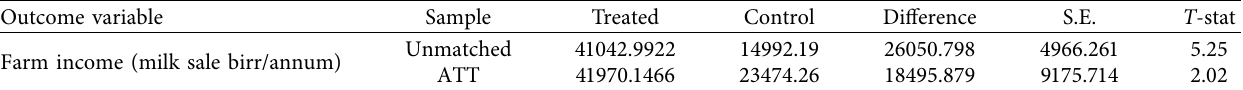
Table 11: Estimation of ATT for farm income (birr/annum).